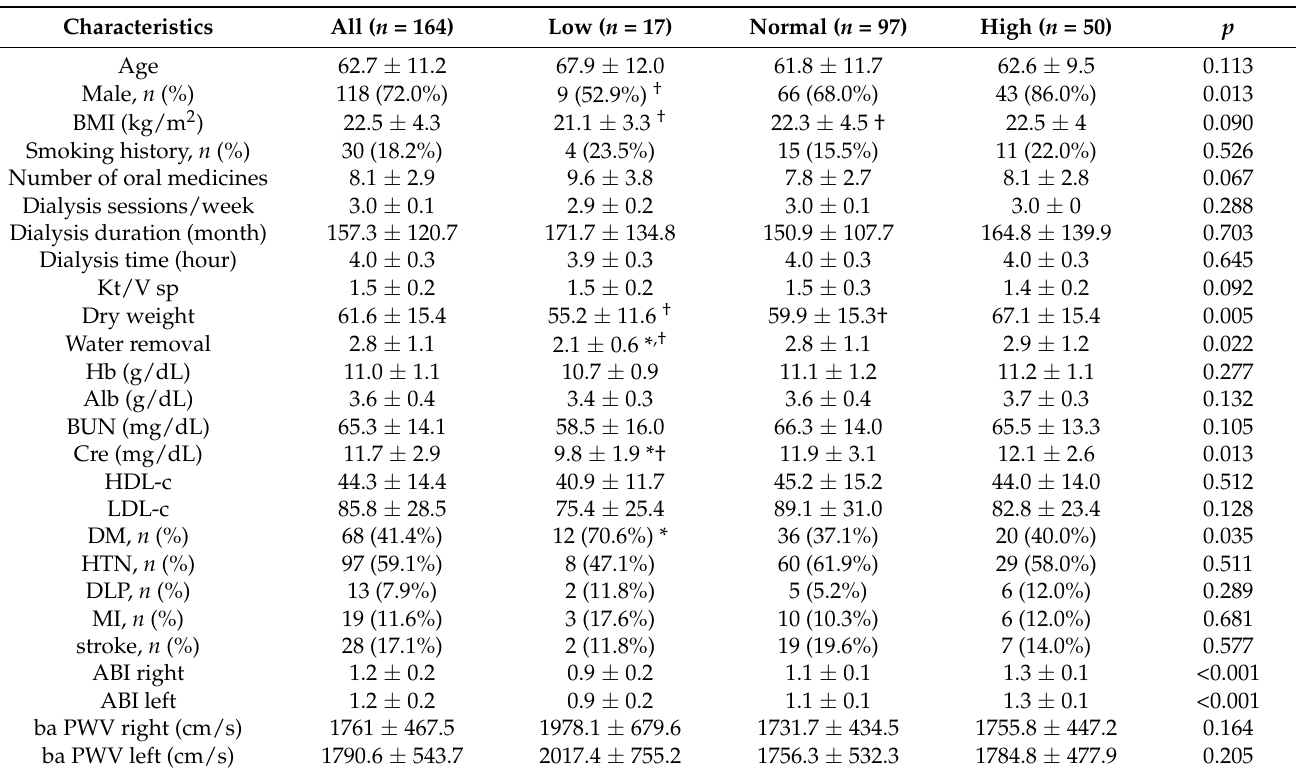
Table 1. Patients’ clinical